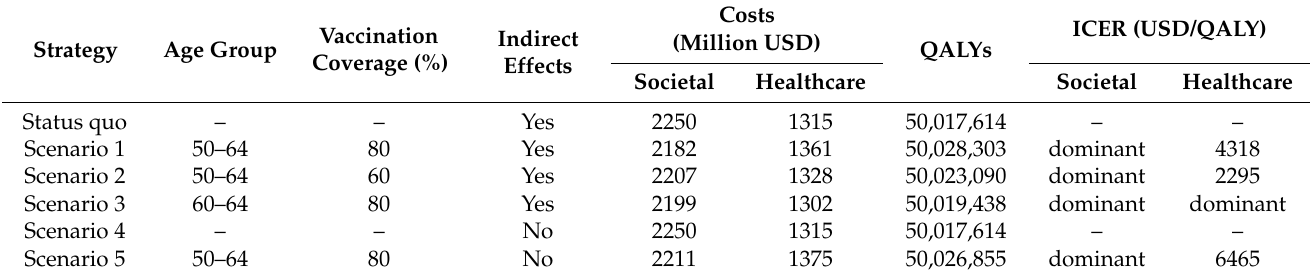
Table 5. Cost and incremental cost-effectiveness ratio for base case and various